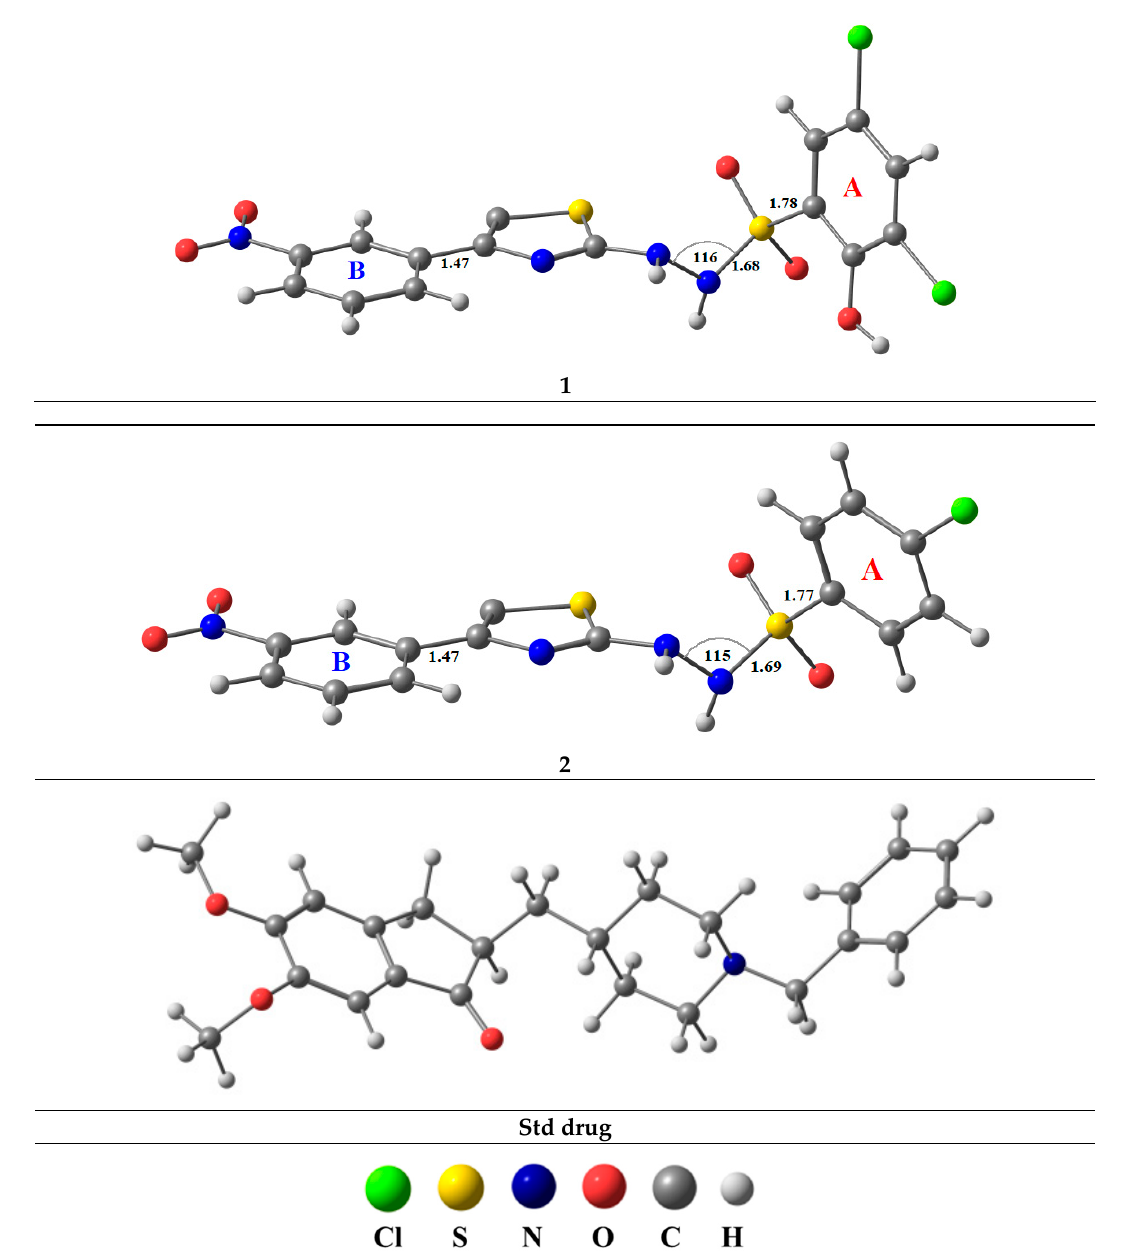
Figure 15. Optimized structures of representative thiazole-bearing sulfonamide analogs 1 and 2 and std drug at the ω B97XD/6–31 g (d,p) level of